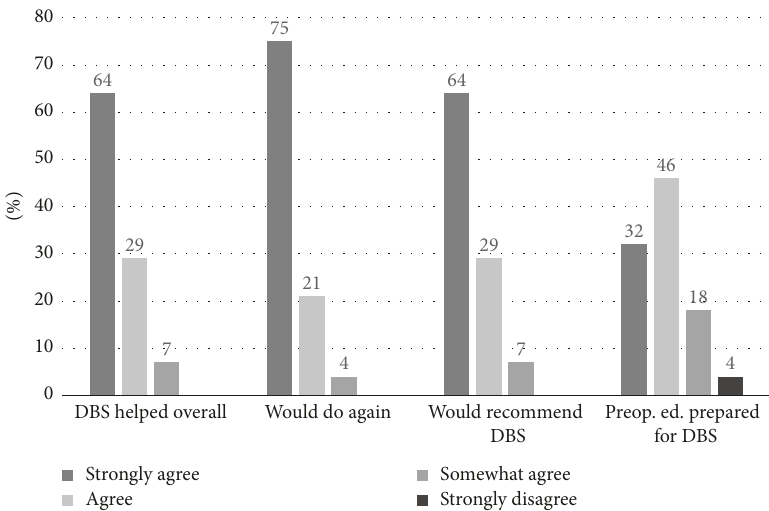
Figure 1: Patient satisfaction with DBS outcomes and preoperative education.